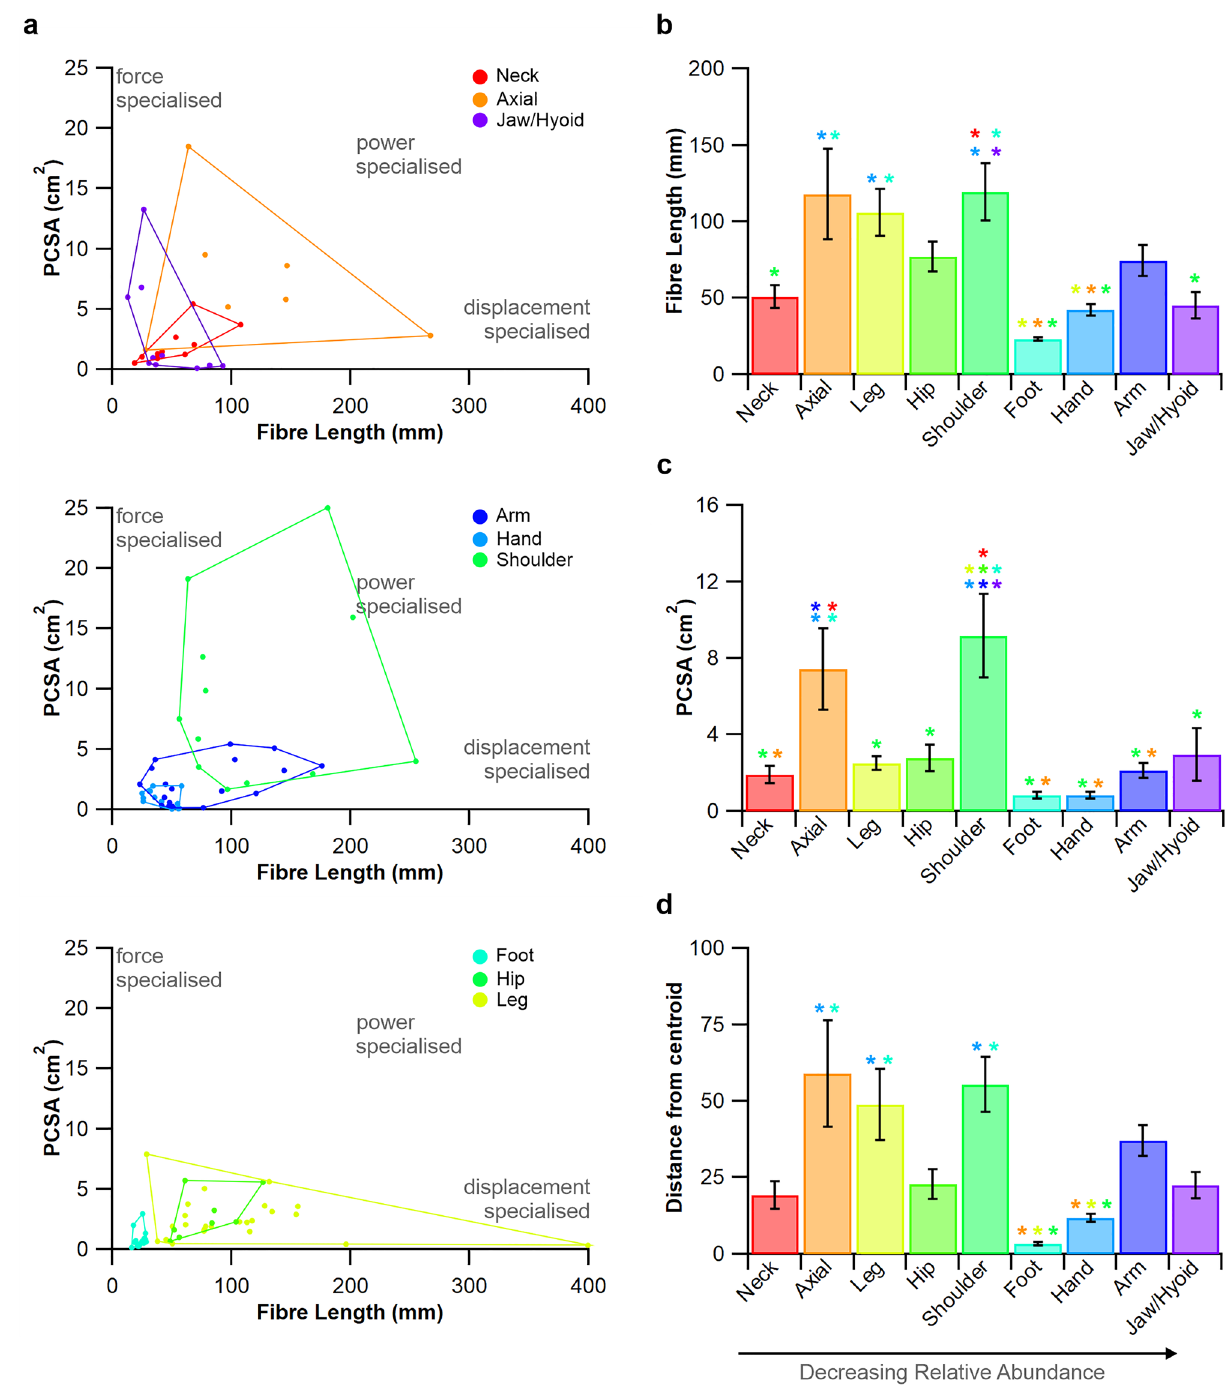
Figure 4. Morphospace plots of regional body parts. To discern potential anatomical parameters that might underpin such regional differences in spindle abundance we have plotted muscle architectural parameters for each of the nine body regions ( a ). Averaged muscle fibre lengths ( b ) PCSA ( c ) and architectural disparity: the mean distance of each individual muscle from the centroid of the outlined area ( d ). * P <